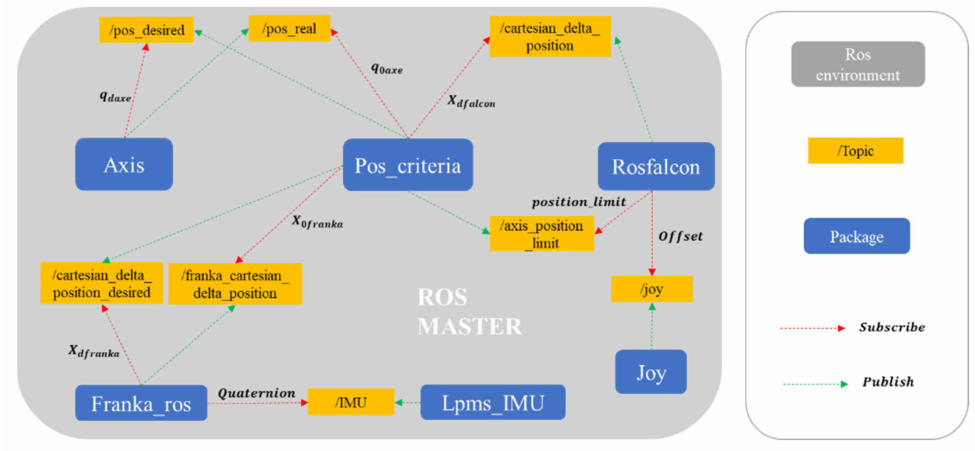
Figure 5. Data exchange of the platform in ROS environment.